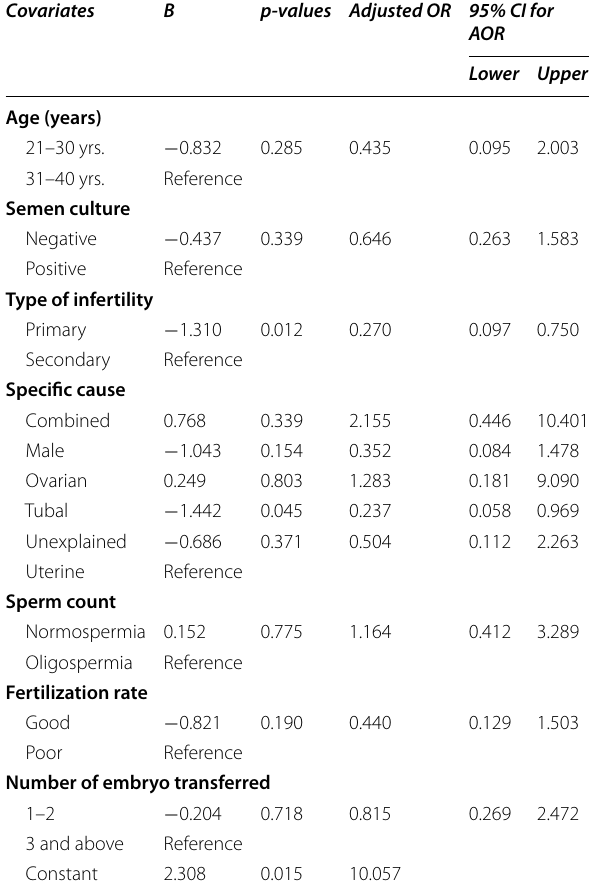
Table 5 Logistic regression model